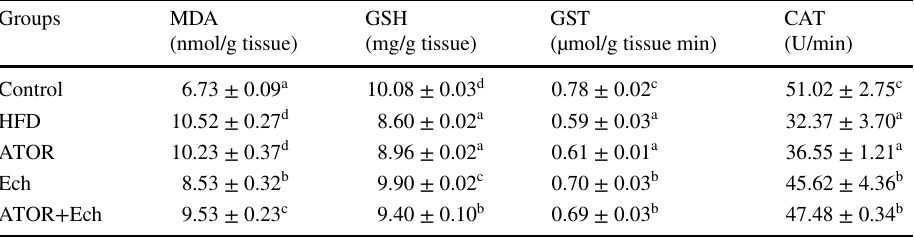
Table 5 Effect of Ech and ATOR on kidney oxidative stress biomarkers in hyperlipidemic rats